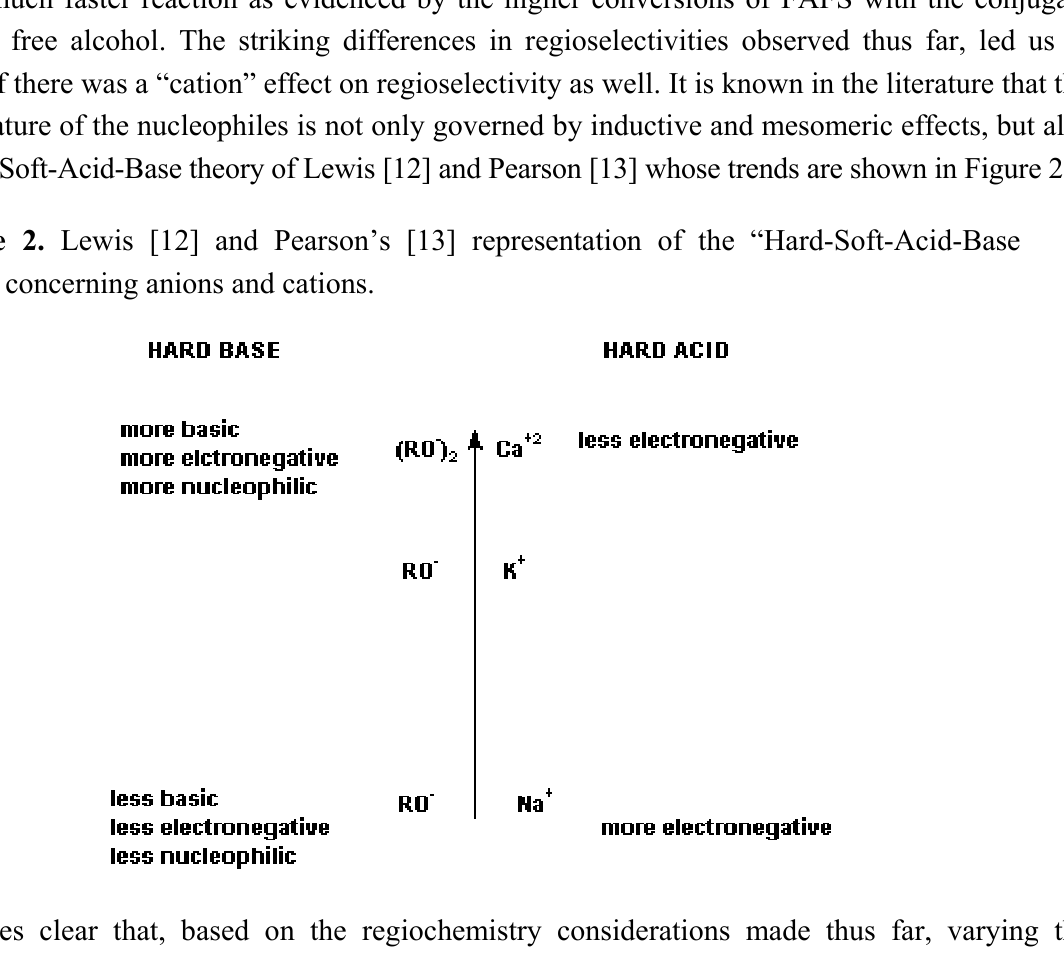
Table 5. Correlation between an oxygen nucleophile’s pK